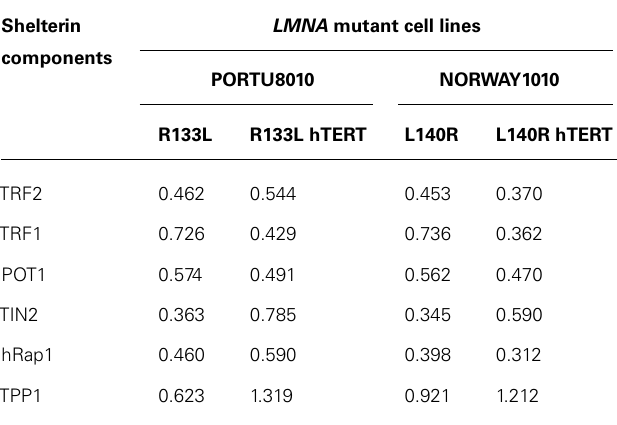
Table 1 | Mean values of relative protein levels of shelterin components in primary and hTERT-immortalized fibroblasts of LMNA mutant cell lines. Protein levels in mutant lines were normalized to the average in controls, 82-6 and 82-6 hTERT.